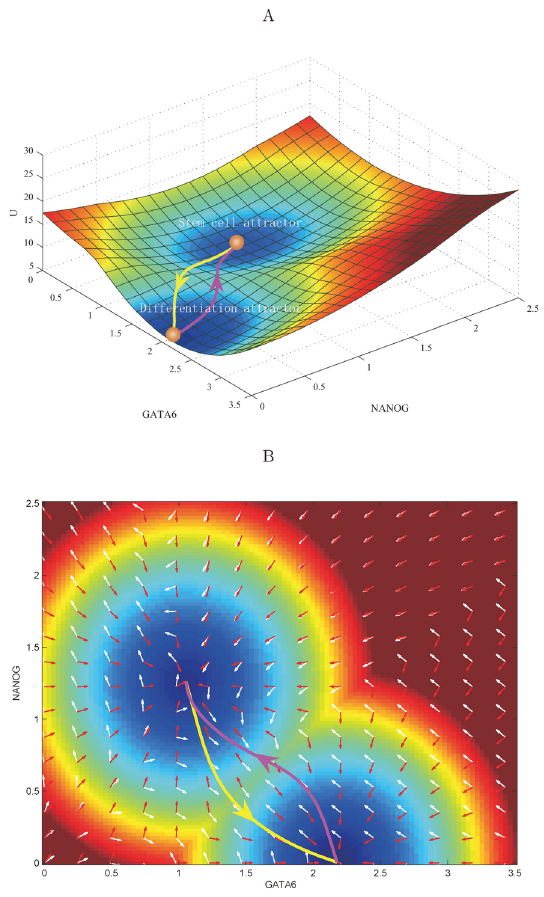
Figure 2. A bistable landscape picture for the stem cell network. Parameters are specified as: k ~ 1 (degradation), b ~ 0 : 5 (repression), a ~ 0 : 37 (activation), and diffusion coefficient D ~ 0 : 01 . (A) Three dimensional landscape and dominant kinetic paths. The yellow line represents developmental path, and the magenta line represents reprogramming path. (B) Two dimensional dominant kinetic path and flux on the landscape. The white arrows represent the direction of flux, and the red arrow represent the direction of the negative gradient of potential energy. and reprogramming process represented by 313 cell states (nodes, characterized by expression patterns of the 22 marker genes) and 329 transition jumps (edges) between the different cell states (produced by Cytoscape [21]). The sizes of nodes and edges are respectively proportional to the occurrence probability of the corresponding states and paths. Red nodes represent states which are closer to stem cell states, and blue nodes represent states which are closer to differentiation states. In particular, we displayed the 22 dimensional kinetic paths (biological paths) from path integral methods (see methods for the details of path integral), which are shown as green and magenta paths separately for differentiation and reprogramming process (see Table S4 and Table S5 for detailed paths). We can see that the paths for differentiation and reprogramming are irreversible. The irreversibility of the paths implies the time asymmetry which may point out the direction of the development.